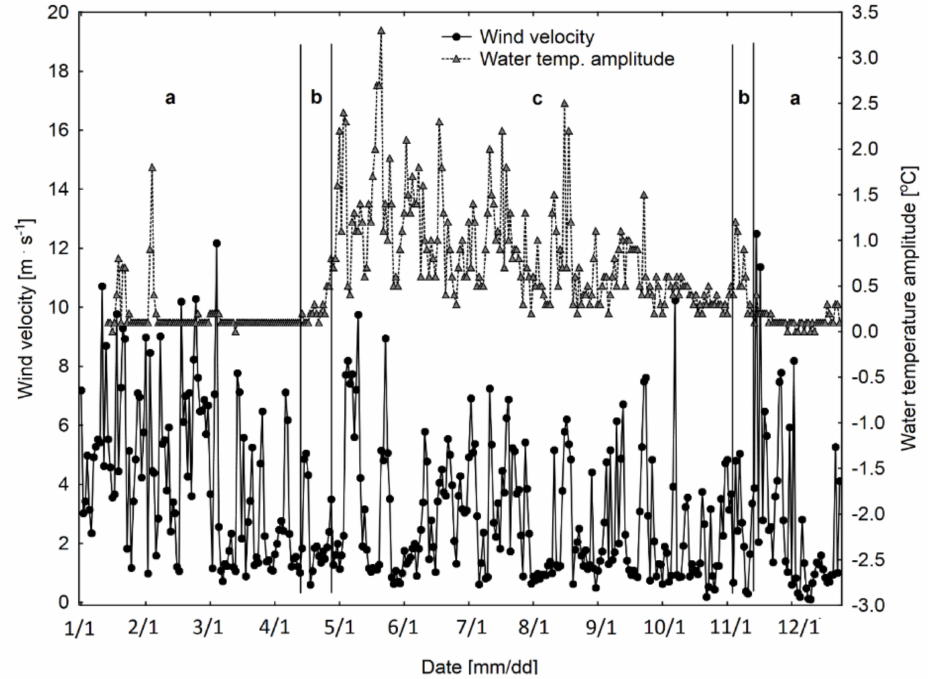
Figure 13. Changes in mean daily wind velocity and water temperature amplitudes in time at a depth of 1 m. a—presence of ice cover; b—occurrence of ice phenomena; c—lack of ice cover/ice phenomena. The analysis of correlations between air temperature, wind velocity, and water temperature amplitudes at a depth of 1 m is presented in Table 4 and in Figures 12 and 13. A strong correlation occurred between air temperature and water temperature amplitude for profiles of type 1 (R =